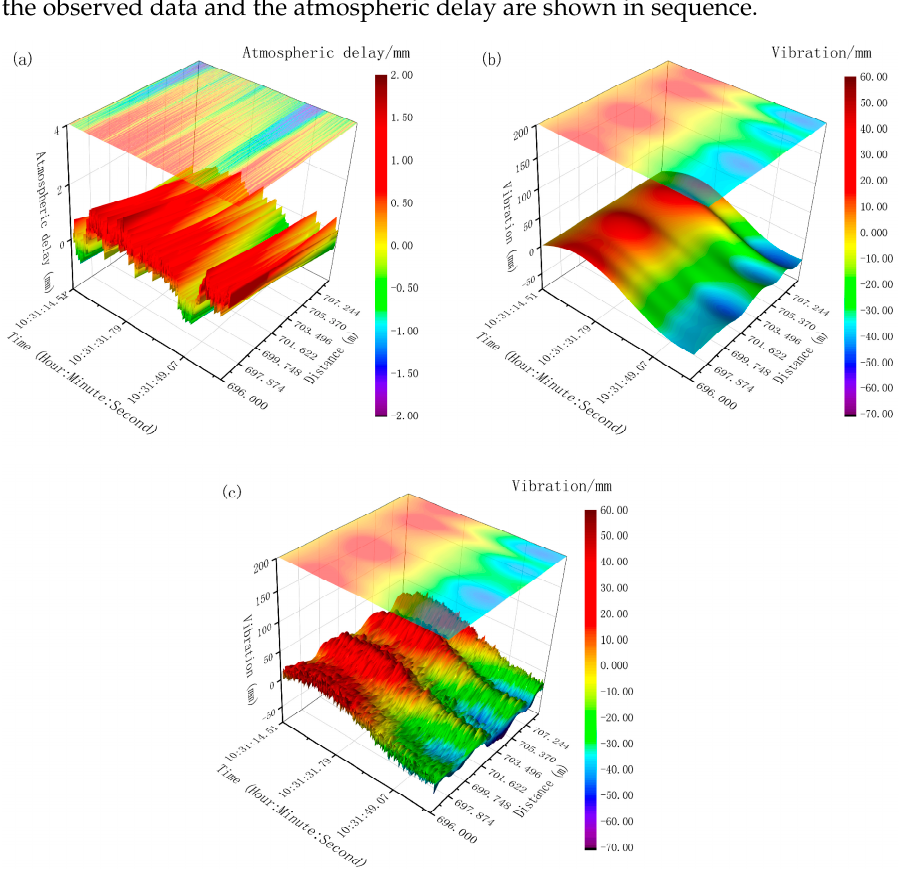
Figure 14. Temporal and spatial variation of a segment of the bridge. ( a ) The atmospheric delay in the LOS direction, ( b ) the vibration fi tt ing result, and ( c ) the di ff erence between the observed data the LOS direction, ( b ) the vibration fitting result, and ( c ) the difference between the observed data and the atmospheric delay. and the atmospheric